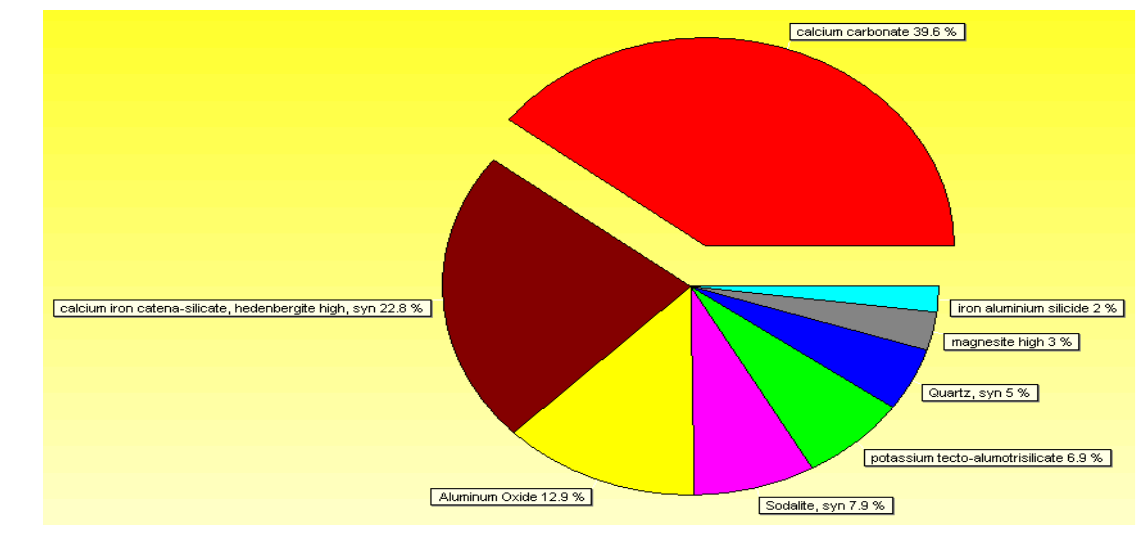
Figure 3. X-ray pattern of the sorbent before wastewater treatment.